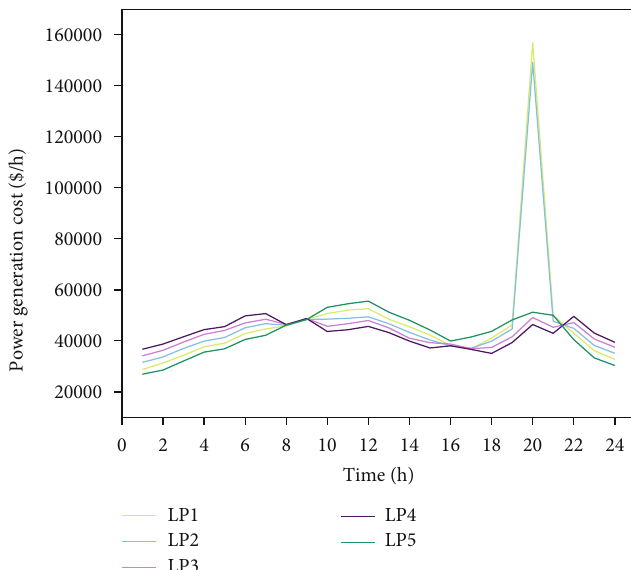
Figure 11: Hourly power generation costs of the 24 h DEDs of the load pro fi les (LPs) at 40% solar penetration under abundant solar resource